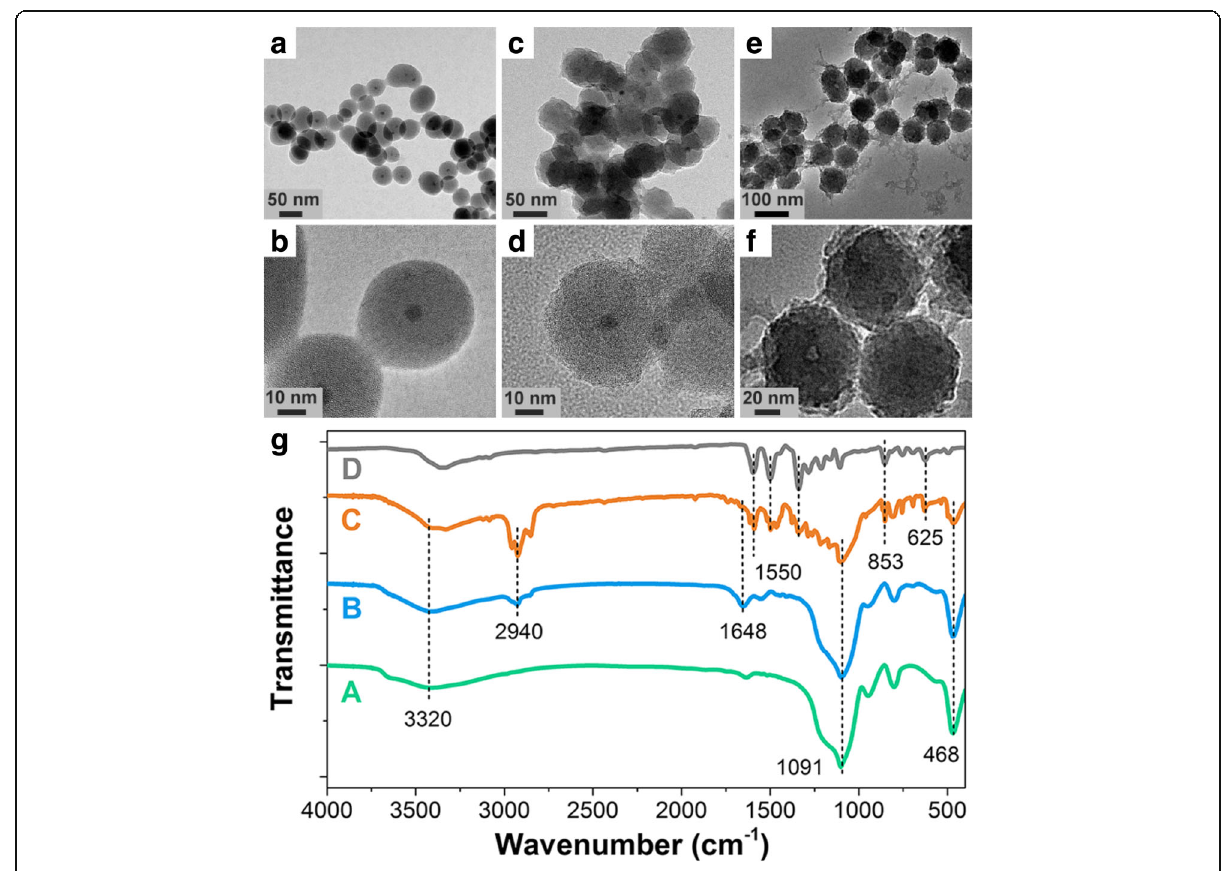
Fig. 1 Characterization of the prepared hybrid nanoparticles. HRTEM images of the CdSe@SiO 2 ( a , b ), CdSe@SiO 2 /CD ( c , d ), and CdSe@SiO 2 /CD/MIP ( e , f ) nanoparticles. And the FTIR spectra ( g ) of CdSe@SiO 2 (curve A), CdSe@SiO 2 /CDs (curve B), CdSe@SiO 2 /CDs/MIP (curve C), and 4-NP (curve